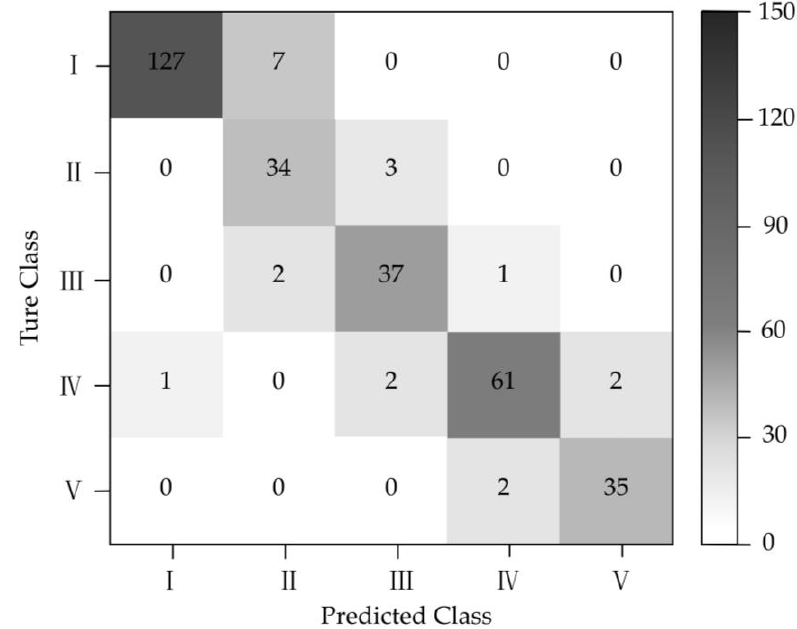
Figure 4. Prediction results of the LightGBM model confusion matrix.